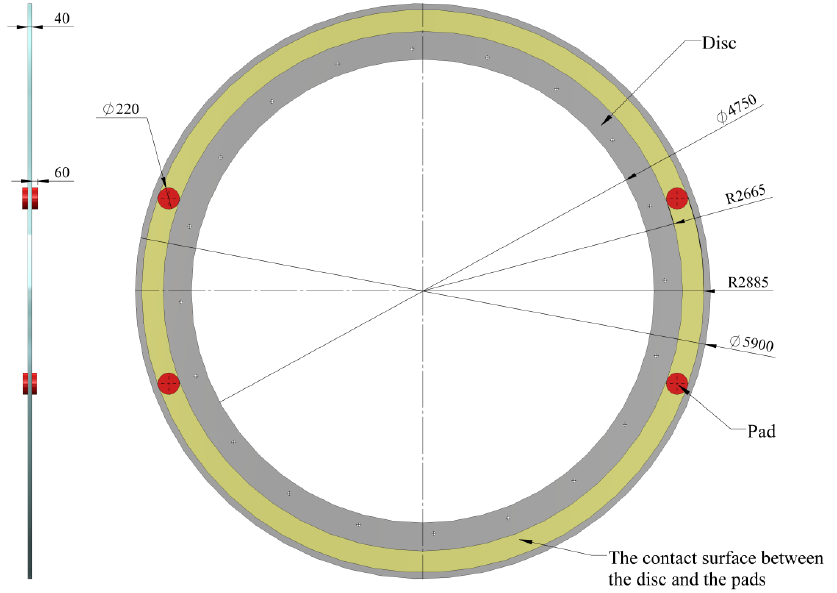
Figure 6. Disc-and-pads configuration with disc, pads and contact surface positioning and dimen- sions. (Unit: mm.